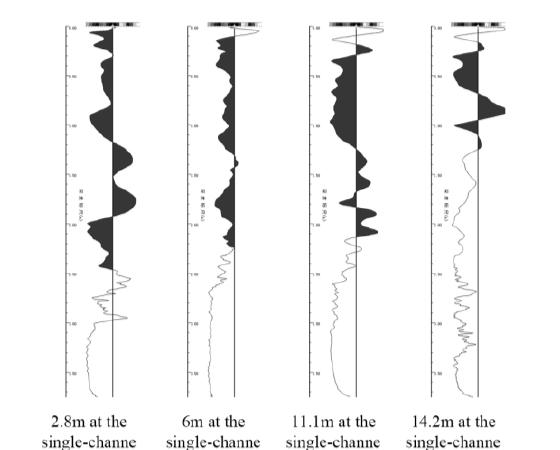
Figure.6. GPR detection analysis of the southeast of